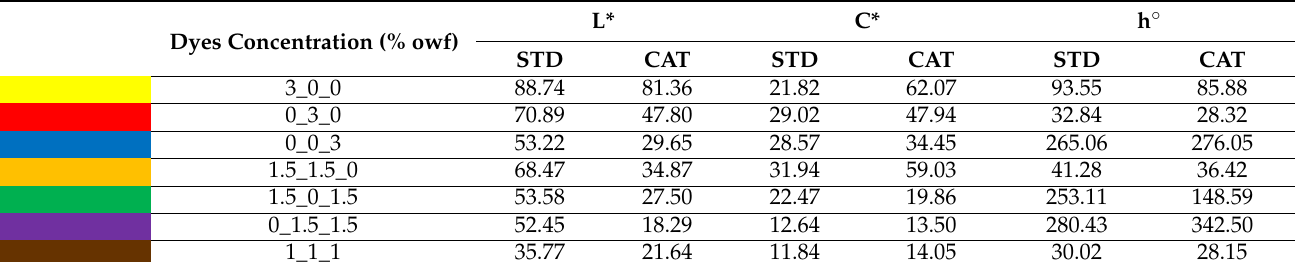
Table 4. Color parameters of standard and cationized fabrics dyed with 3% owf vat dye. Dyes Concentration (%